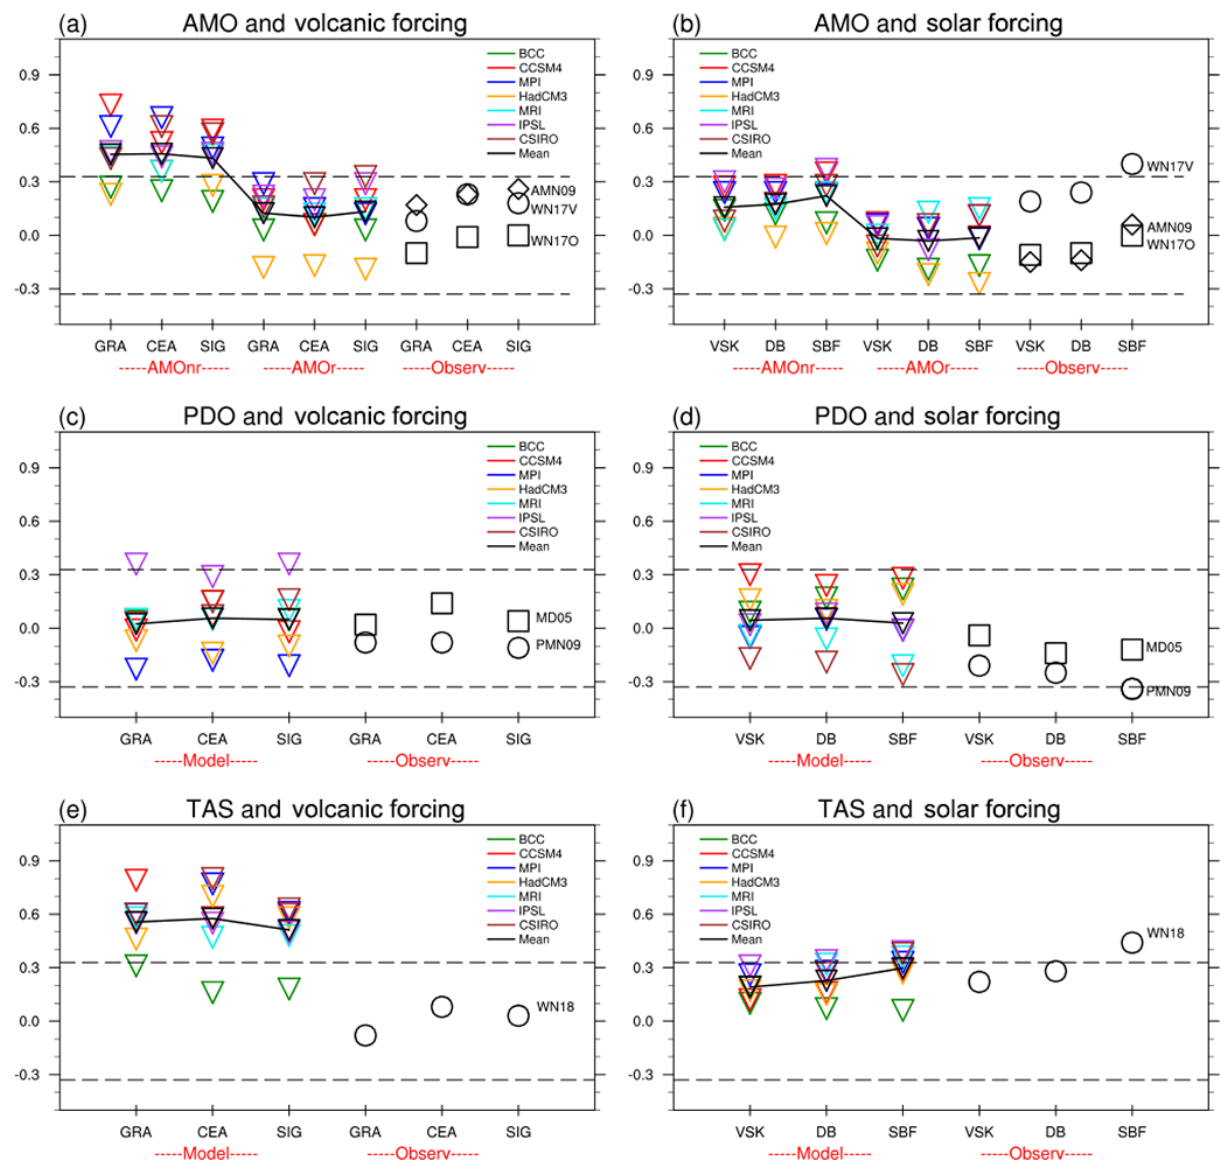
Figure 8. The correlations of annual-mean AMO, PDO and TAS with volcanic forcing (a, c, e) and solar forcing (b, d, f) for each GCM (triangles) and reconstruction (circle, square and diamond). The threshold values for the individual correlations significant at 95% level using a two-tailed Student’s t test are marked as dashed lines. The means of the seven model correlations are shown by black triangles connected by black